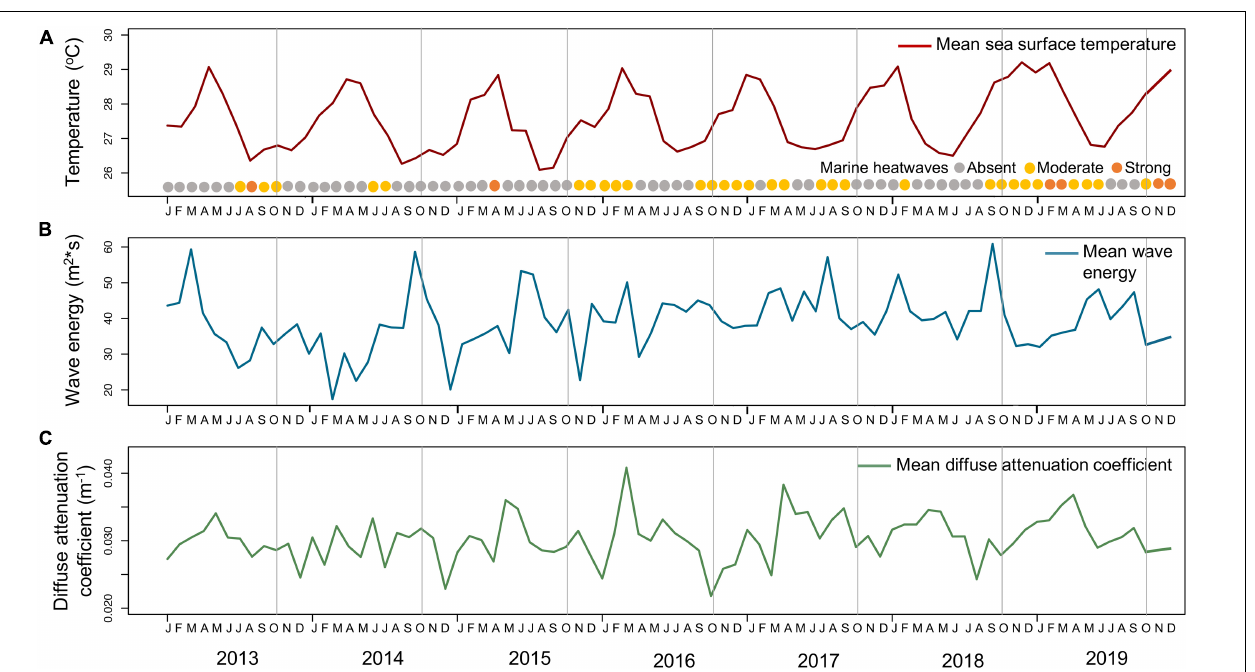
FIGURE 2 | Oceanographic setting. (A) Monthly mean sea surface temperature (solid red line) during the 7-year monitoring in Fernando de Noronha Archipelago. Circles indicate the absence or presence of marine heatwaves per month and their category (gray—absent; yellow—moderate; orange—strong). (B) Monthly mean wave energy (solid blue line) during the 7-year monitoring in Fernando de Noronha Archipelago. (C) Monthly mean diffuse attenuation coefficient (solid green line) during the 7-year monitoring in Fernando de Noronha Archipelago. Sampling months are indicated by vertical solid gray